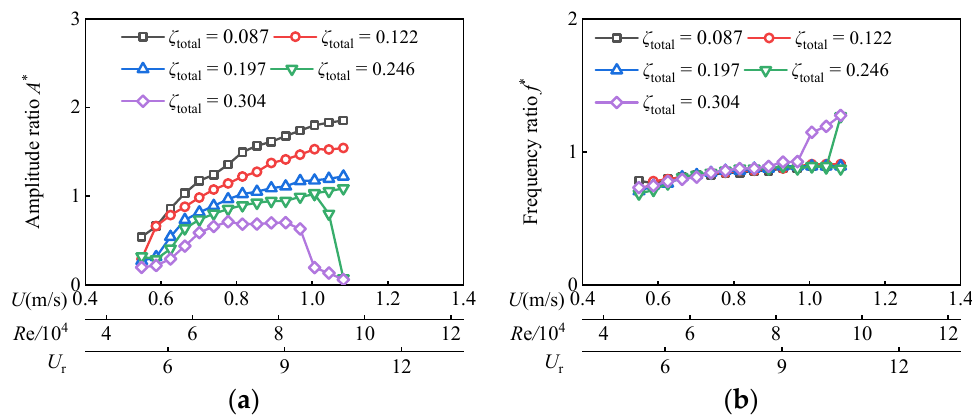
Figure 7. FIM of Cir-T-Att with D = 0.10 m, Re = 4.82 × 10 4 ~9.50 × 10 4 . ( a ) Amplitude ratio. ( b ) Frequency ratio.